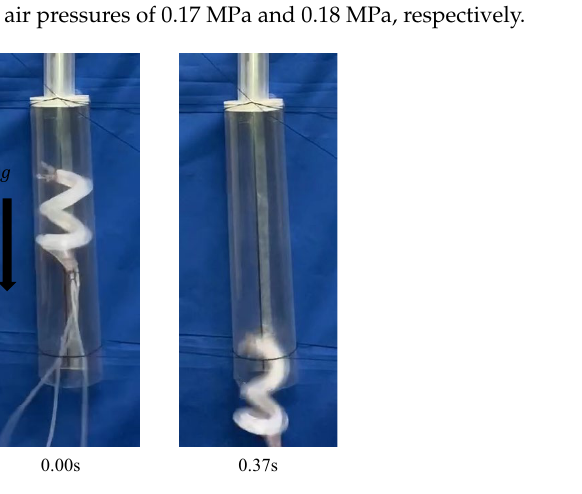
Figure 21. Experiment using a uniform pitch device driven by an air pressure of 0.20 MPa into a vertically fixed pipe with the same diameter as that of the 50A and 20A